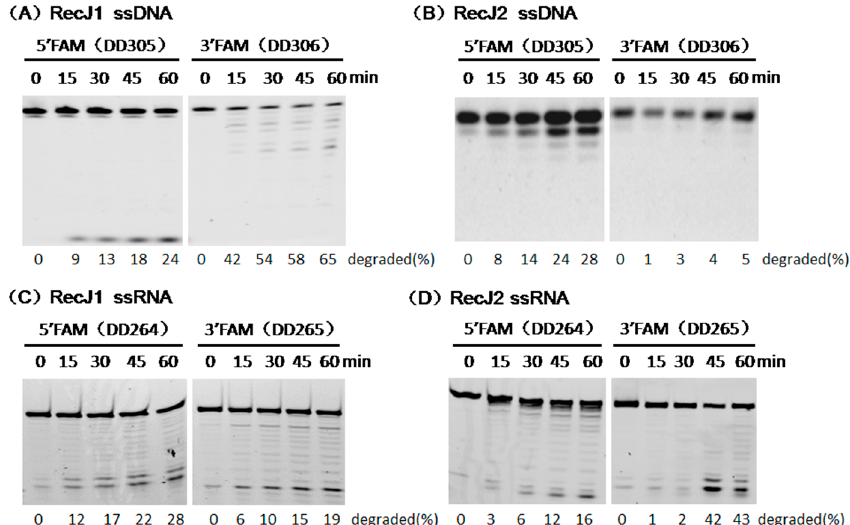
Figure 4. Hydrolysis polarities of two MjaRecJ nucleases. Two MjaRecJs (1.5 μ M MjaRecJ1 or 10 μ M MjaRecJ2) were incubated with fully phosphothioate-modified 200 nM 23 nt ssDNA or 17 nt ssRNA substrates in their respective reaction buffer at 55 °C with increasing time. SsDNA and ssRNA are labeled with fluorescence group fluorescein FAM at 5 ′ or 3 ′ end, respectively. The degraded amount of substrate was quantified at each time and listed at the bottom of the panel.